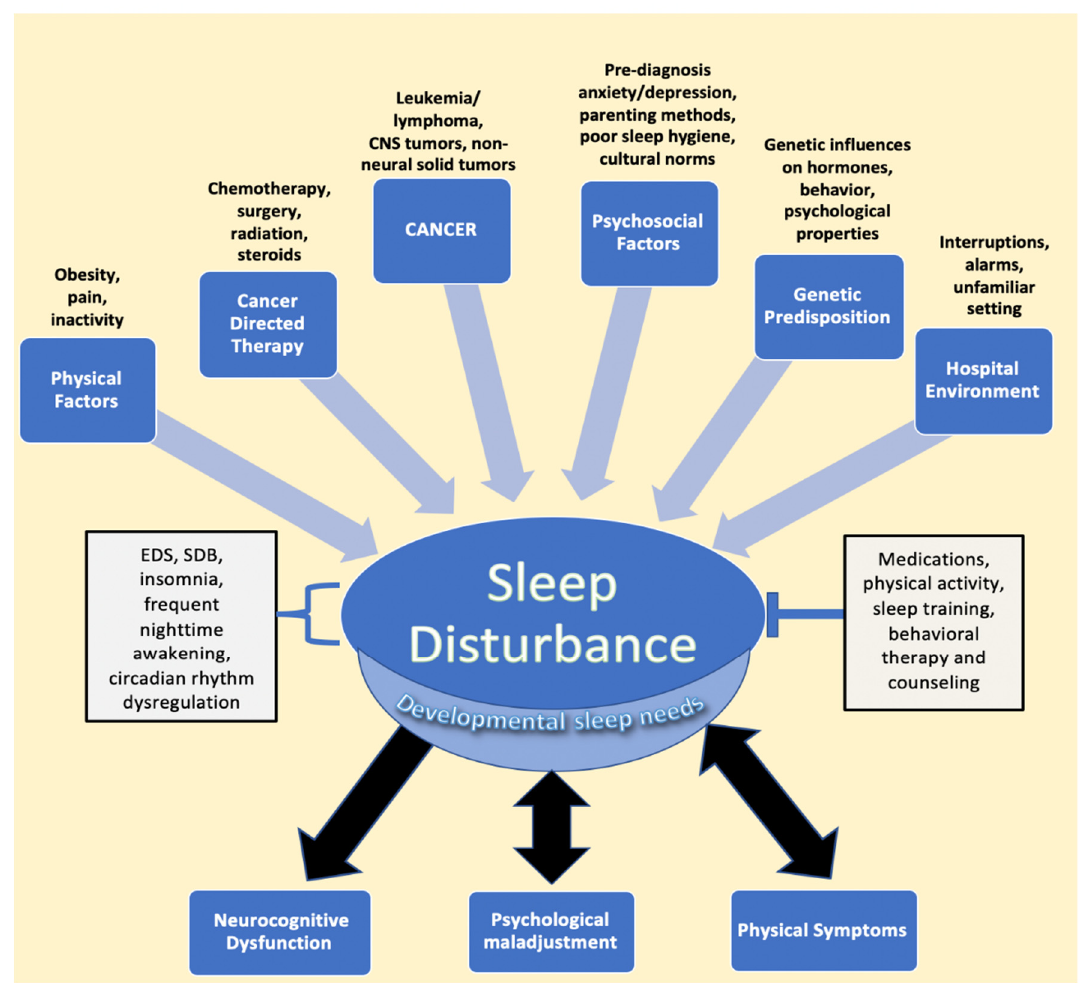
Figure 1. Factors impacting sleep in children diagnosed with cancer. The figure describes the various entities described in the literature that lead to sleep disturbance, followed by the resulting sequalae of negatively impacted sleep. EDS, SDB, frequent nighttime awakening, and circadian rhythm dysregulation are components of disturbed sleep, while interventions such as medications, physical activity, sleep training, and counseling represent mitigating factors that relieve sleep issues. Developmental sleep needs are affected globally by sleep disturbances, despite the fact that children of different ages require different amounts of sleep. Psychological maladjustment and physical symptoms, such as pain, have been found to have a bidirectional relationship with sleep issues. Abbreviations: CNS, central nervous system; EDS, excessive daytime sleepiness; SDB, sleep disordered breathing.